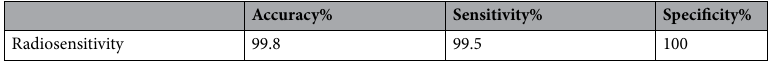
Table 2. Random forest prediction of radiosensitivity vs. radioresistance evaluation.